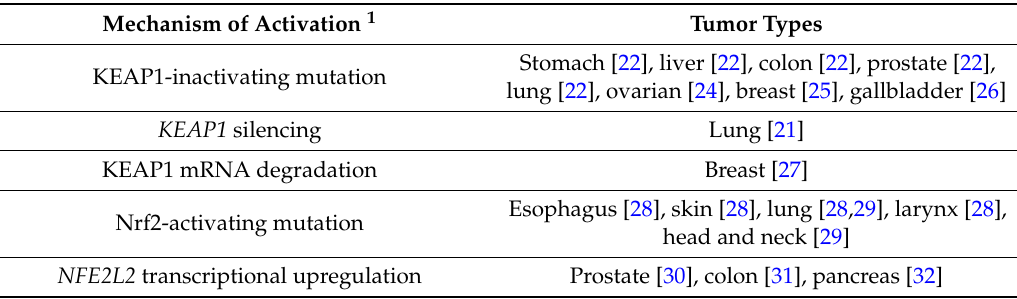
Table 1. Mechanisms of constitutive Nrf2 signaling in